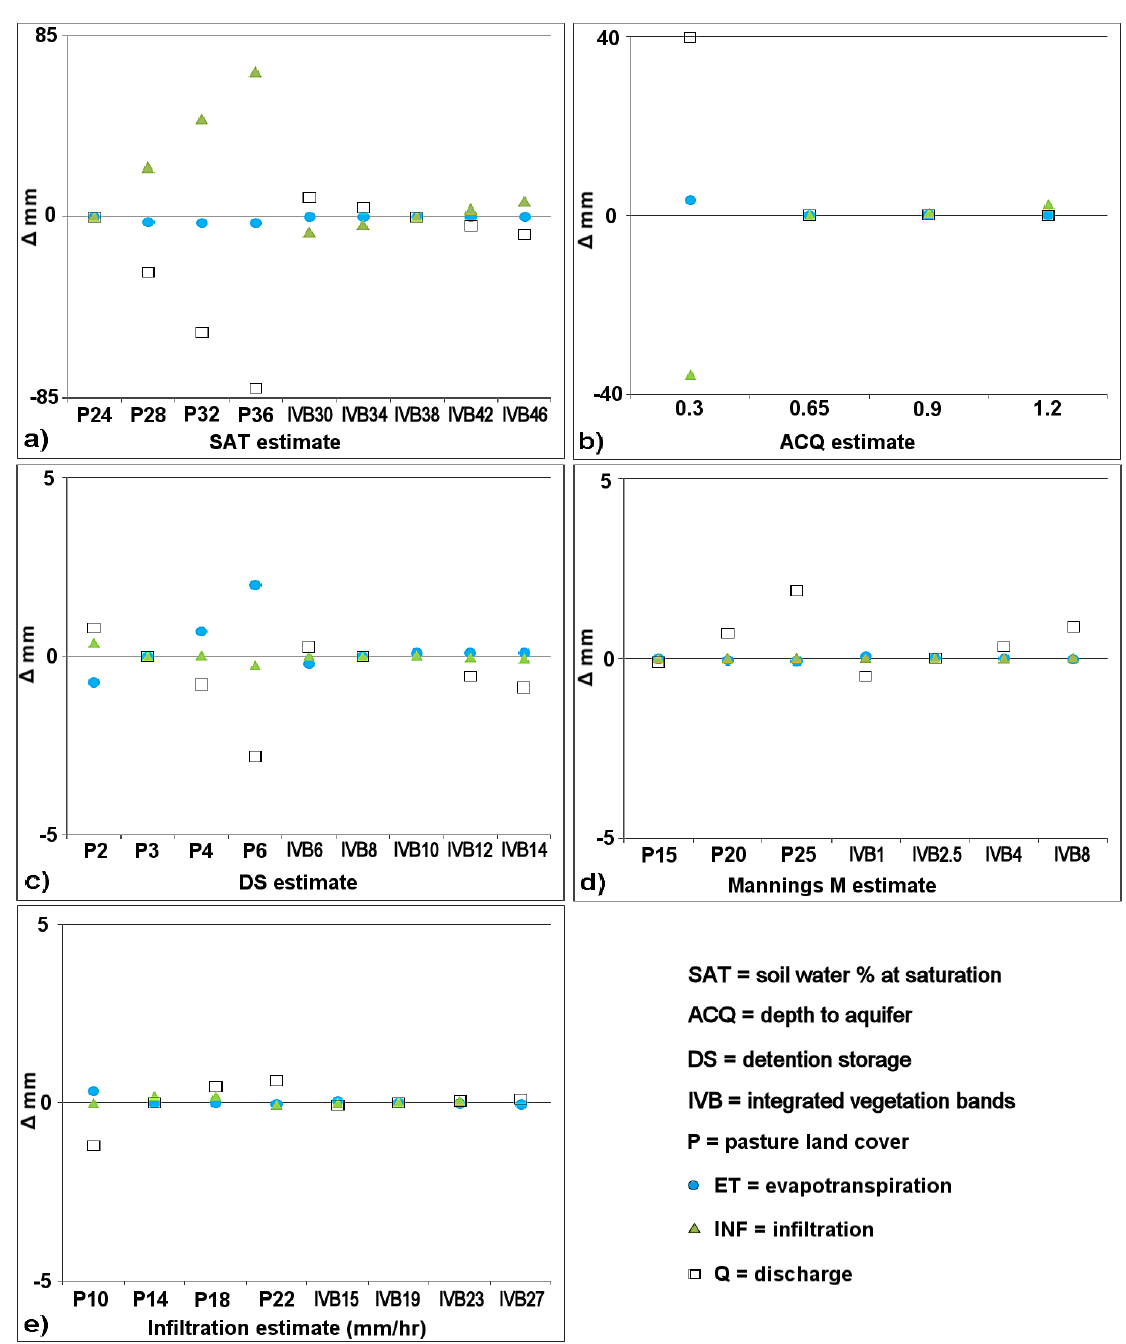
29.33; Q σ 34.87) than for comparable IVB simulation runs ( ET σ 0.05; INF σ 5.71; Q σ 6.79). This implies that SAT has a major bearing on the retention of runoff on hillslopes when it decreases through land use management ( i.e. , grazing on steep slopes).